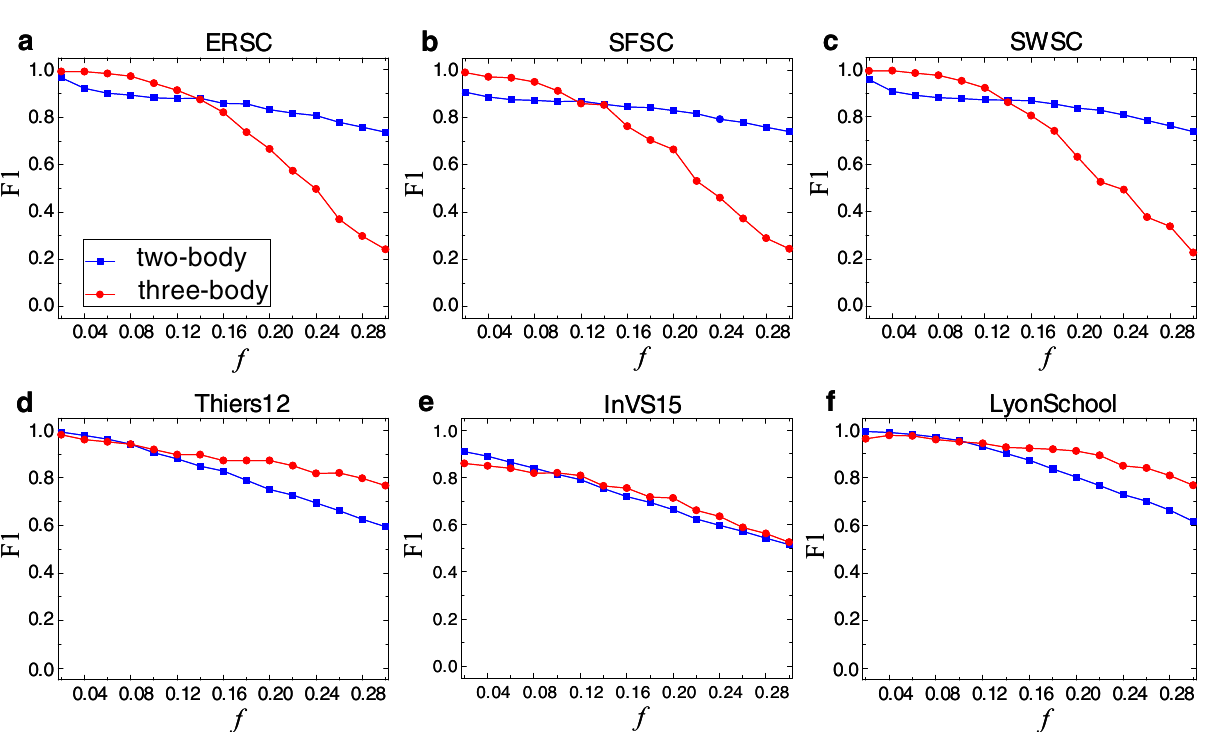
Fig. 3 Effect of random fl ipping ratio f on reconstruction performance for synthetic and real-world simplicial complexes. Shown is the F1 score for ( a ) random simplicial complex (ERSC), ( b ) scale-free simplicial complex (SFSC), ( c ) small-world simplicial complex (SWSC), ( d ) Thiers12, ( e ) InVS15, and ( f ) LyonSchool. The blue squares and red circles demonstrate the reconstruction performance of two-body and three-body connections, respectively. The parameter values for the synthetic simplicial complexes are N = 200, k 1 = 12, k 2 = 4, T = 10,000, α = 0.8, ω = 2.4, ρ 0 = 0.2, and μ = 1. For the real-world simplicial complexes, the parameter values are T = 20,000, α = 0.3, ω = 1, ρ 0 = 0.2, and μ = 1. Each data point is the result of averaging over ten